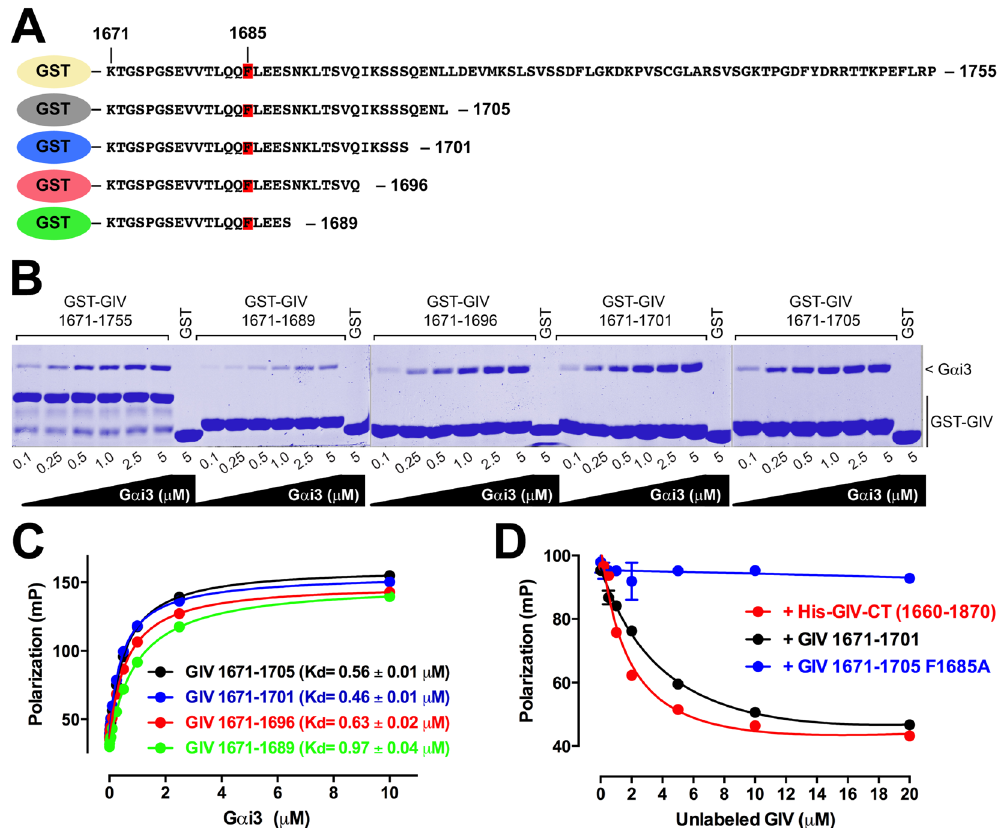
Figure 2. GIV 1671–1701 sequence is sufficient to bind G α i3 with sub- µ M affinity. ( A ) Scheme of GST-fused GIV sequences used to map the minimal G α i3 binding region. F1685, a residue previously shown to be critical for G α i3 binding, is shown in red. ( B ) Binding of purified G α i3 to GST-GIV truncation constructs. Increasing concentrations of purified His-G α i3 (0.1–5 µ M) were incubated with different GST-GIV proteins and binding determined by pulldown assays as described in Methods . GST-GIV 1671–1689 showed diminished His-G α i3 binding compared to the other GST-GIV proteins. No His-G α i3 binding to the negative control GST was detected. One representative experiment out of three is shown. ( C ) Binding of purified G α i3 to fluorescently- labeled GIV peptides. Increasing concentrations of purified His-G α i3 (0.125–10 µ M) were incubated with the indicated fluorescently-labeled GIV peptides (25 nM). Fluorescence polarization (FP) data were fit to a one-site binding model to calculate the equilibrium dissociation constant (K d ) for each peptide. K d results are expressed as mean ± S.E. of 3 independent experiments and the curves correspond to one representative experiment. ( D ) Competition of unlabeled GIV protein/peptides with fluorescently-labeled GIV 1671–1701 for binding to G α i3. His-G α i3 (1 µ M) was incubated with fluorescently-labeled GIV 1671–1701 (25 nM) in the presence of increasing concentrations (0.5–20 µ M) of His-GIV-CT (1660–1870, colored red) or unlabeled GIV 1671–1701 peptide (black). GIV 1671–1705 peptide containing the F1685A mutation was included as negative control (blue). Results are expressed as mean ± S.E. of 3 independent experiments (error bars not shown if smaller than the symbol). Images of the full gels presented in this figure are shown in Supplementary